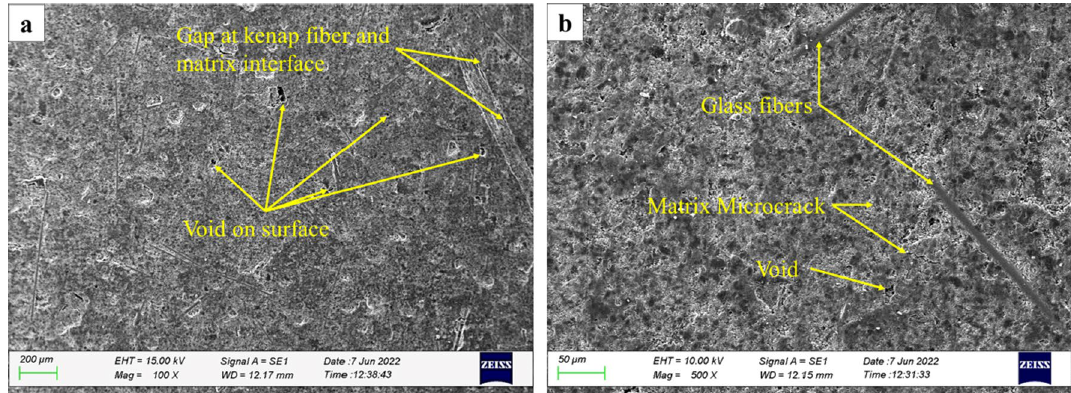
Figure 9. Scanning electron micrographs of the control composites pre-immersion: ( a ) MCC0 and ( b ) MCC12.